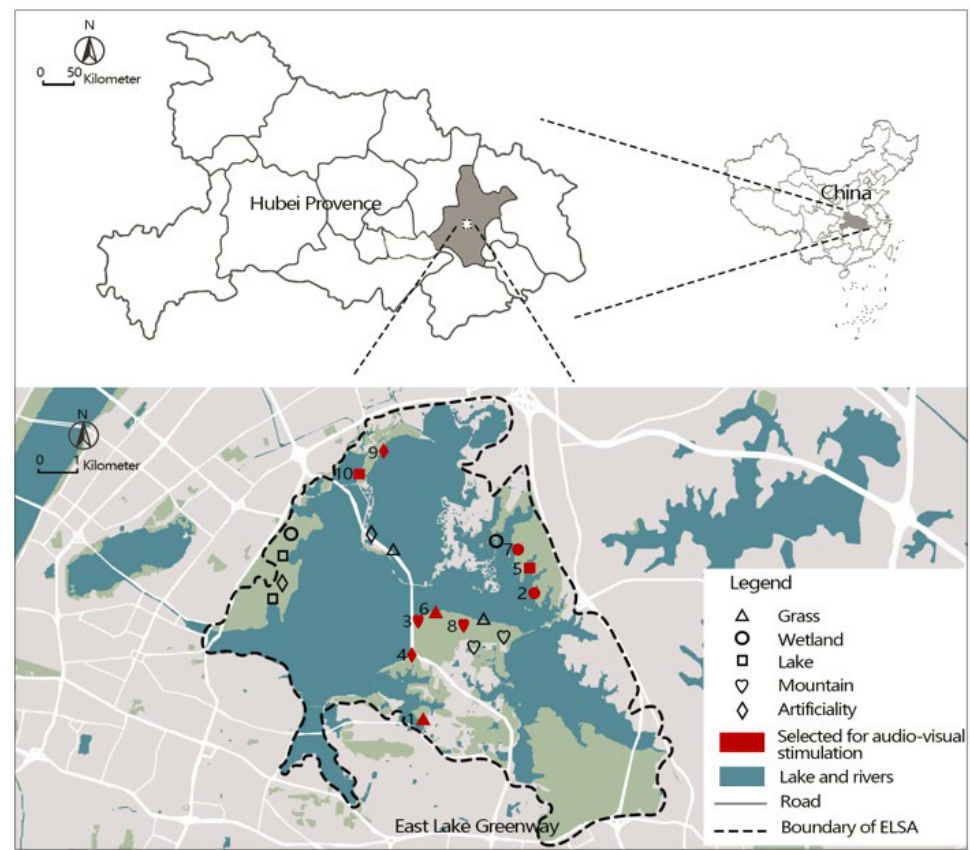
Figure 1. The study area and ranking of image collection; the figure shows the position of 20 im- ages, of which 10 red ones were selected for audio-visual